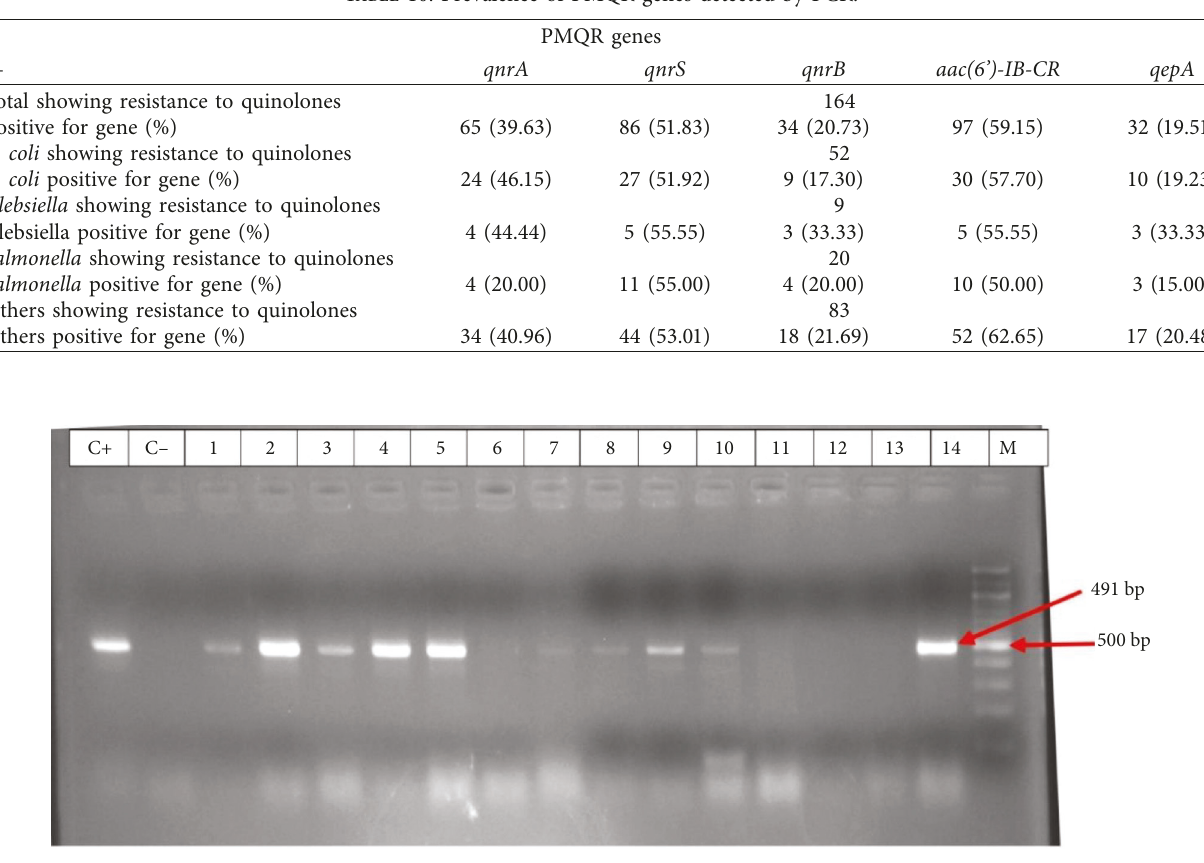
Figure 8: Gel image showing the amplification of the qnrS gene fragment at